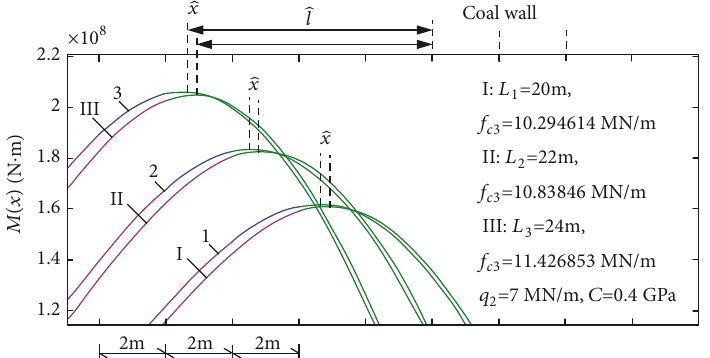
Figure 15: Enlarged drawings at peak part of rock beam bending moment with the increasing of the distance of overhang roof.